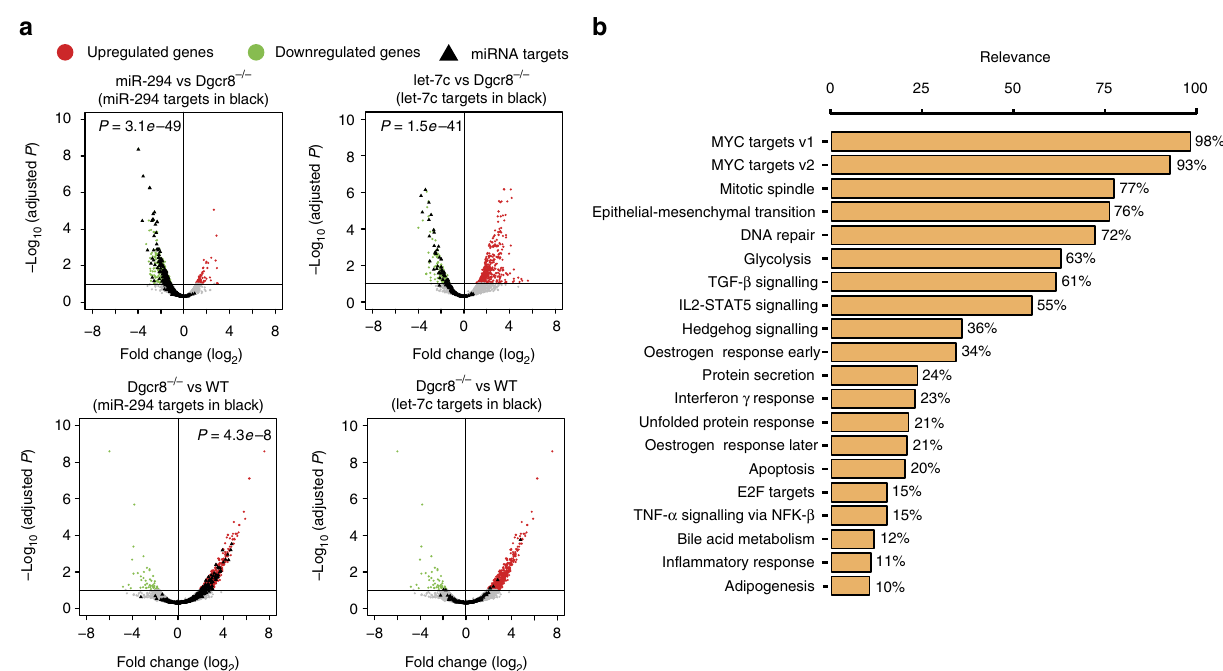
Figure 2 | Differential gene expression of mESC transfected with either miR294 or let-7c. ( a ) Volcano plots showing expression fold change of mean across cells in each condition on x axis and -log 10 (FDR) on y axis. Individual cells within a condition were treated as repeats for differential expression analysis. Significantly differentially expressed miRNA targets (FDR o 10%) for miR-294 and let-7c identified in previous population-based array experiments are highlighted as black triangles and P -values for the enrichment analysis is shown in upper left corner. miR-294 and let-7c targets are similarly highlighted in Dgcr8 (cid:2) / (cid:2) versus WT mESC comparison. Conversely to let-7c, miR-294 is broadly expressed in mESC and its targets are significantly upregulated in miRNA-deficient Dgcr8 (cid:2) / (cid:2) cells versus WTmESC. ( b ) Identification of discriminant processes between miR-294 and let-7c- transfected cells. Pathways are sorted according to their relevance by mean of the frequency they were selected by the RFE method to correctly assign a cell to its category. Only pathways selected at least in 10% of 1,000 trials are